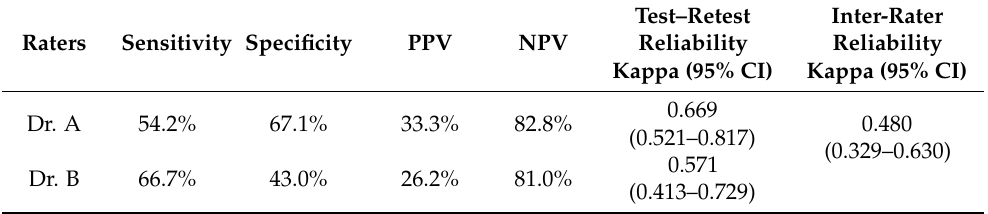
Table 2. Validity and reliability of the oculomotor test interpretations of the two specialists.